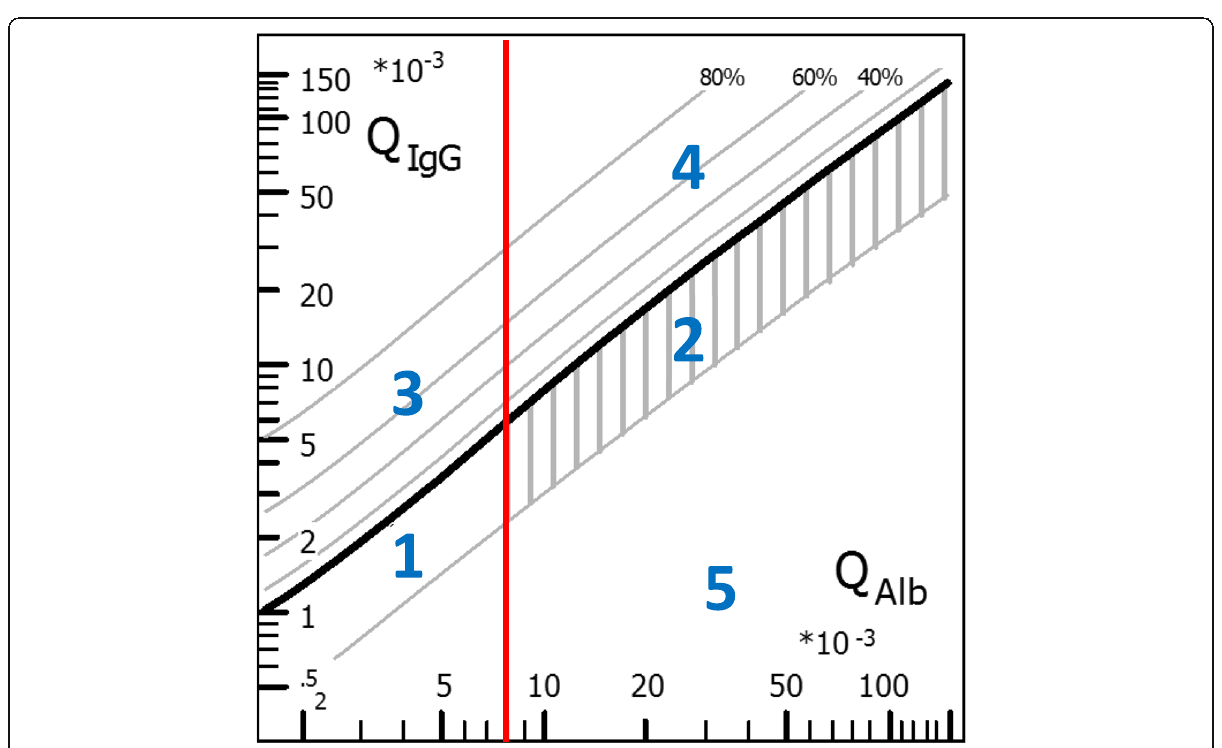
Fig. 2 Quotient diagram. Logarithmically the albumin quotient is plotted against the IgG quotient. The thick diagonal line represents the QLim. This corresponds to the mean value of the expected IgG concentration plus 3 times the standard deviation. For IgG quotients above this line, an intrathecal IgG synthesis can therefore be assumed with a probability of a false-positive result of < 0.5%. The red vertical line represents the age- related limit value for barrier function (formula: age/15+ 4, the upper normal range of a 60-year-old person would be 8 × 10 − 3 ). This results in different areas with differently interpreted findings (and disease examples). An advantage of the quotient diagrams over a numerical calculation is that typical finding constellations can be assigned to a disease at a glance: Possible constellations resulting from QIgG and QAlb are: (1) Normal findings, e.g., no indication of inflammatory CNS process. (2) Isolated barrier dysfunction, e.g., Guillain-Barré syndrome or spinal canal stenosis. (3) Isolated inflammation in the CNS, e.g., multiple sclerosis or past infectious encephalitis. (4) The combination of (2) and (3), e.g., acute neuroborreliosis, neurotuberculosis. (5) Implausible findings (e.g., high-dose hook effect, puncture soon after immunoglobulin